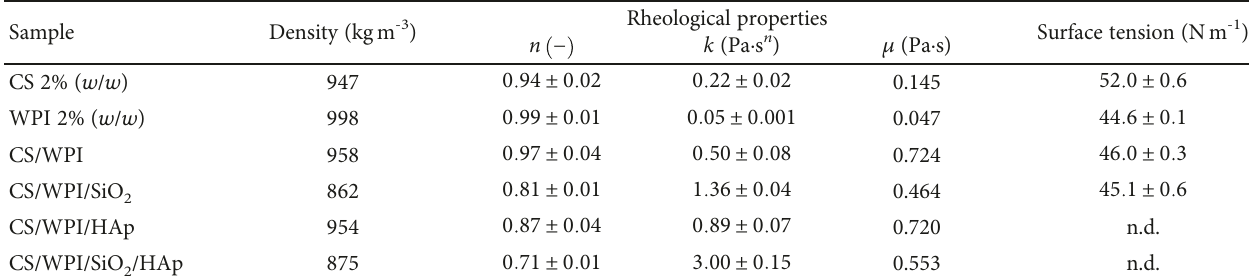
Table 2: Density, rheological properties, and surface tension of raw